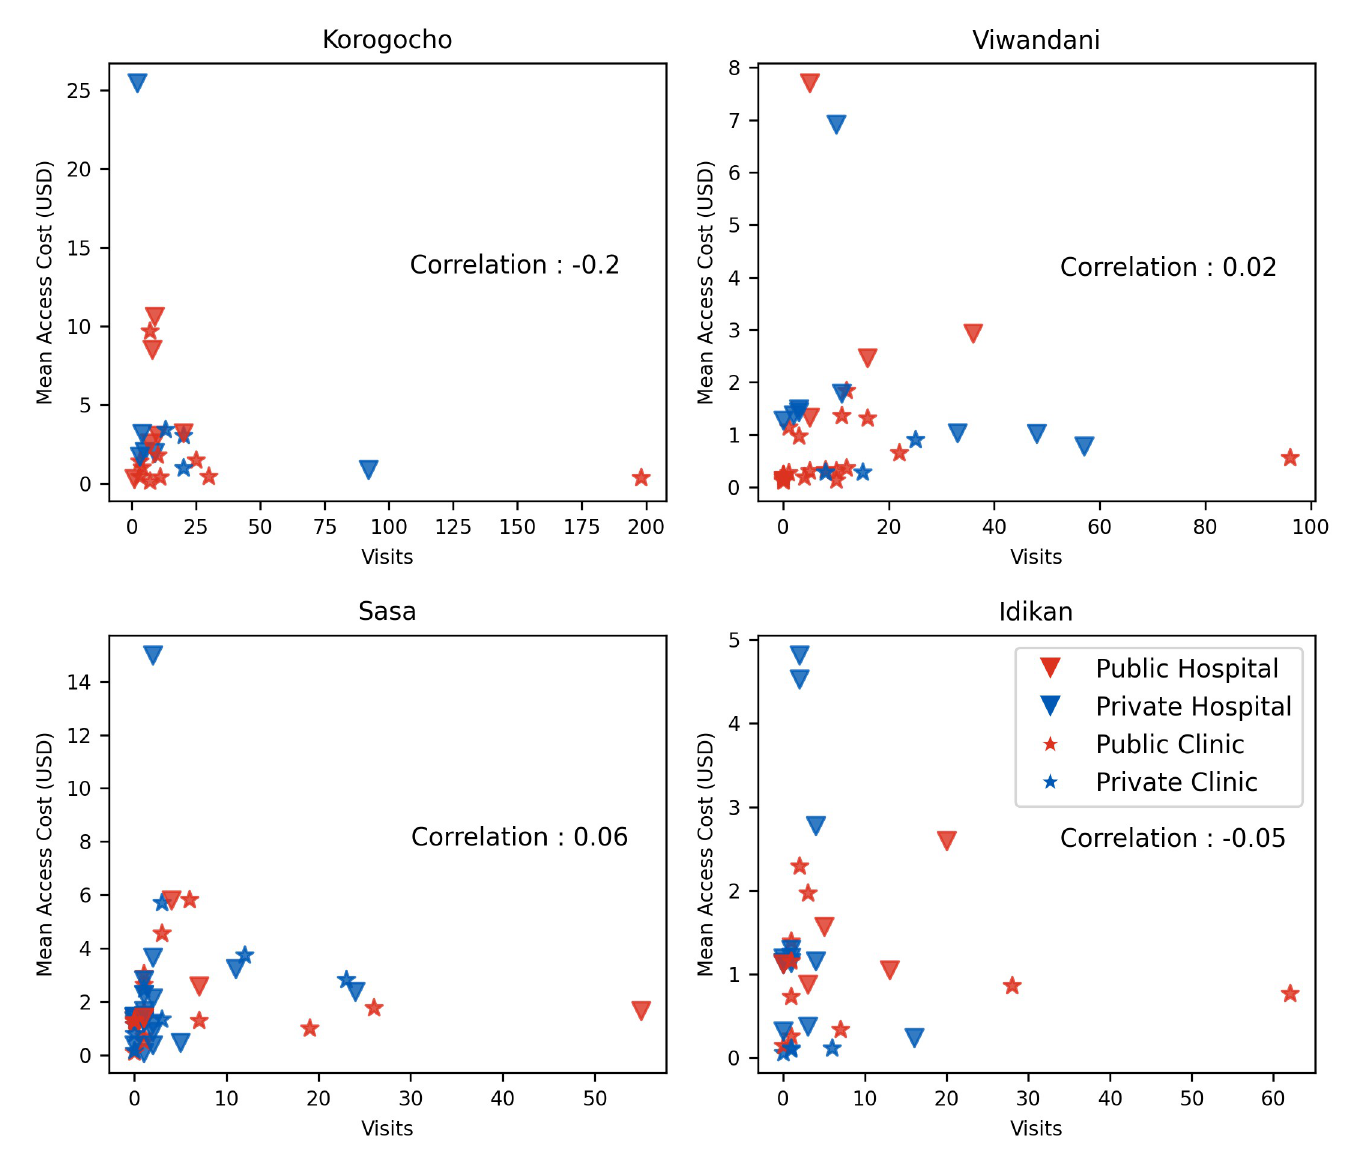
Fig 5. Scatter plot of HCPs in each slum showing recorded visit number against access cost with Pearson correlation coefficient.